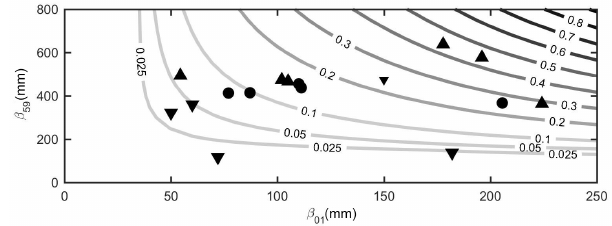
Figure 7. Landslide triggering probability P L as a function of 1-day and 59-day cumulative